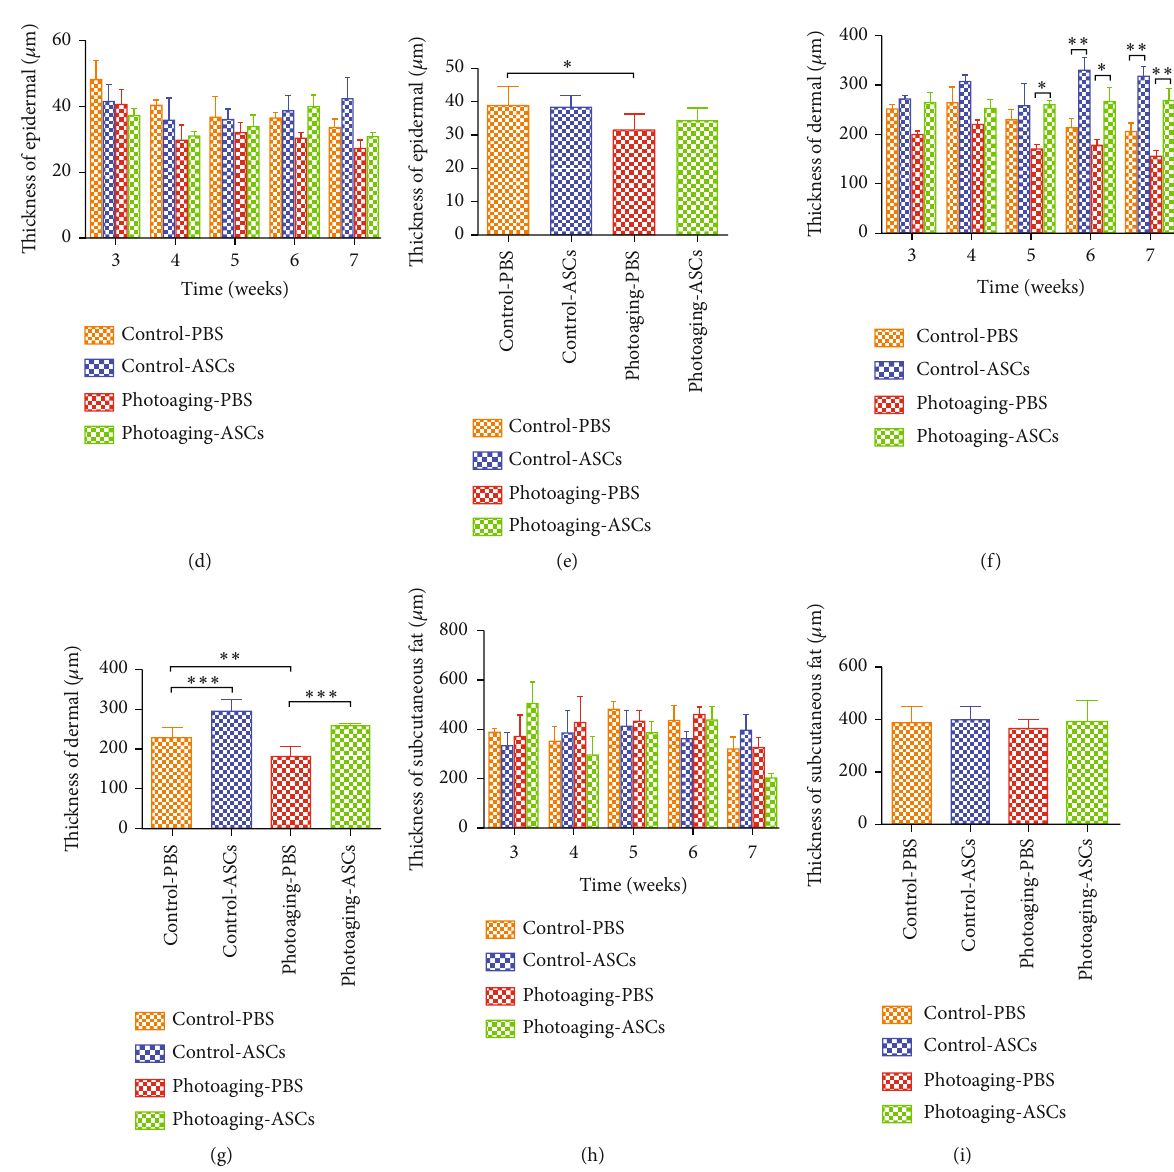
Figure 2: Histological analysis of the mice skin. (a) Schematic illustration of the in vivo study. (b) H&E staining. (c) Masson ’ s trichrome staining. (d, e) Epidermal thickness analysis. (f, g) Dermal thickness analysis. (h, i) Subcutaneous fat thickness analysis. n = 25 (25 mice per group, 3 areas analyzed for each